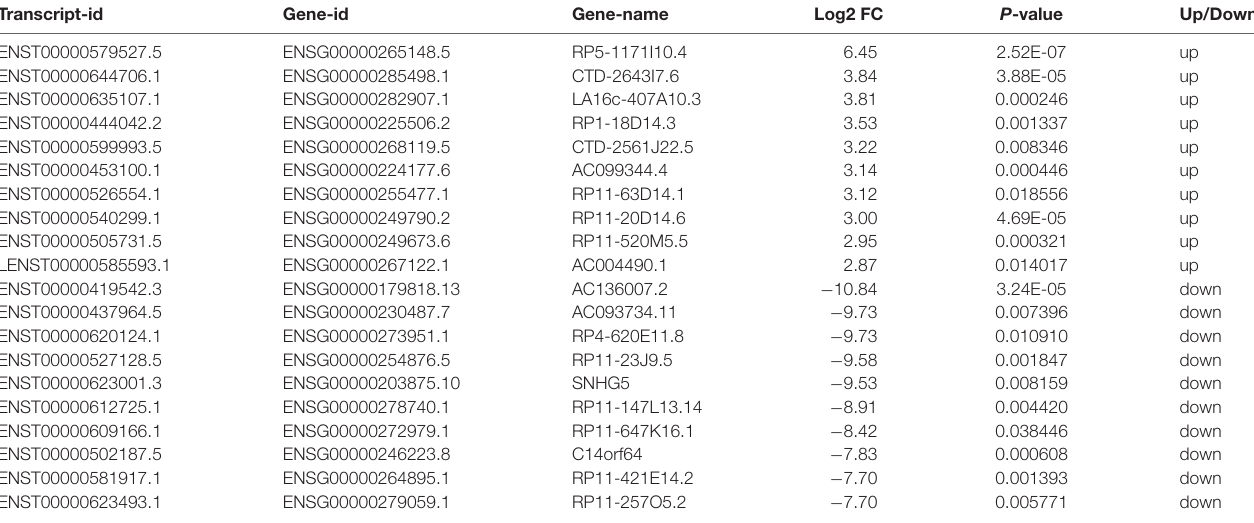
TABLE 2 | Top 10 upregulated and downregulated known lncRNAs (patients with AIS vs. healthy controls).